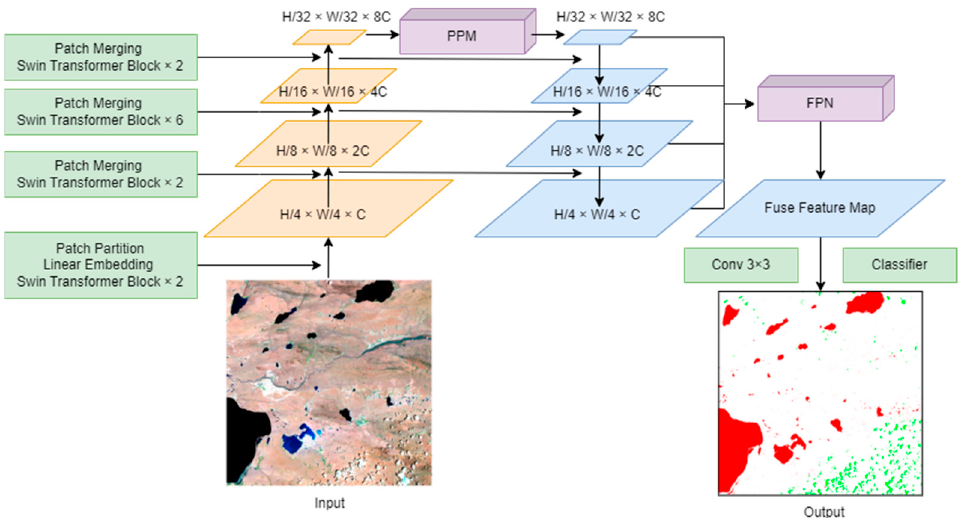
Figure 2. The structure of the water body extraction network.